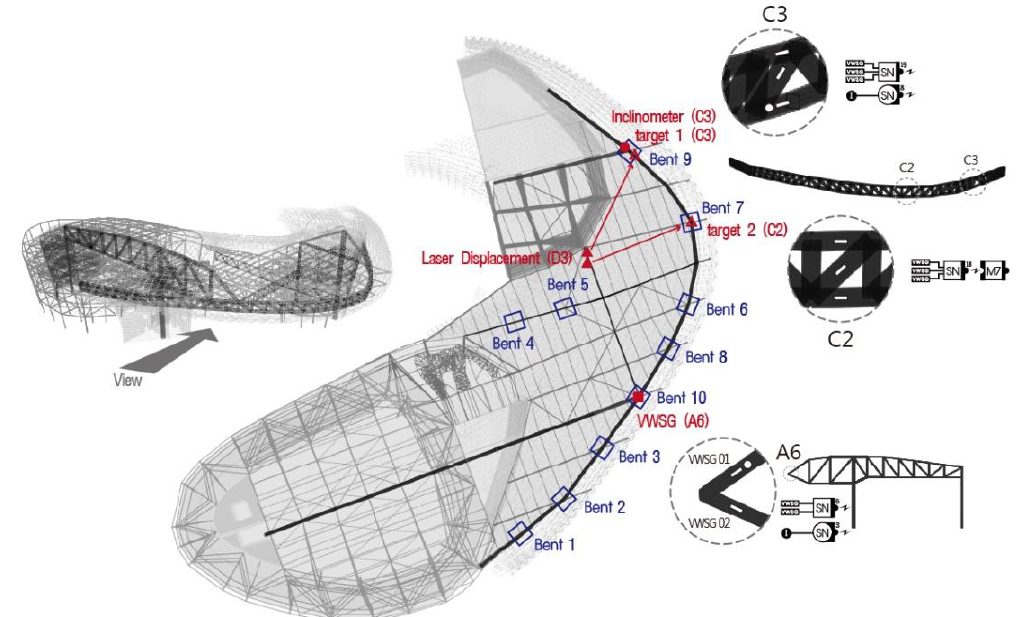
Figure 11. Measuring points and bent locations (Bent No. indicates the order of bent removal.).